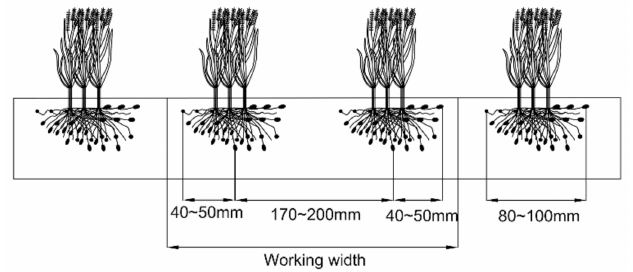
Figure 6. Cyperus esculentus planting